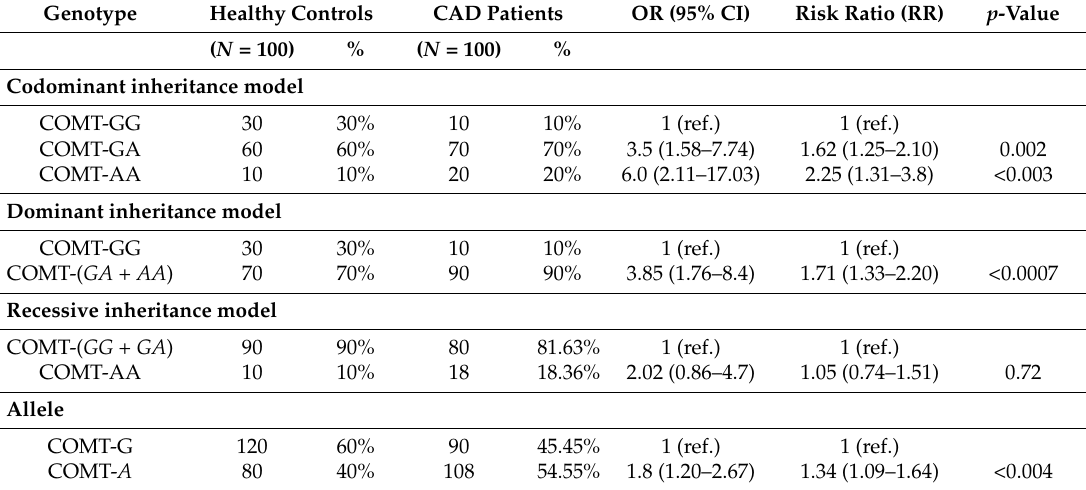
Table 6. Association of COMT rs4680 G/A gene variation with coronary artery disease.